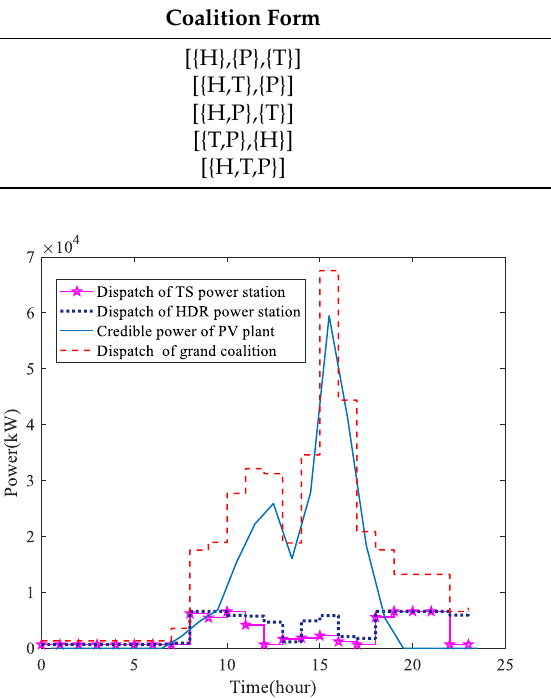
Figure 6. The coordinated operation of hot dry rock-thermal storage-photovoltaic ( HDR - TS - PV) coalition. Table 3. The overall payoff of each coalition.